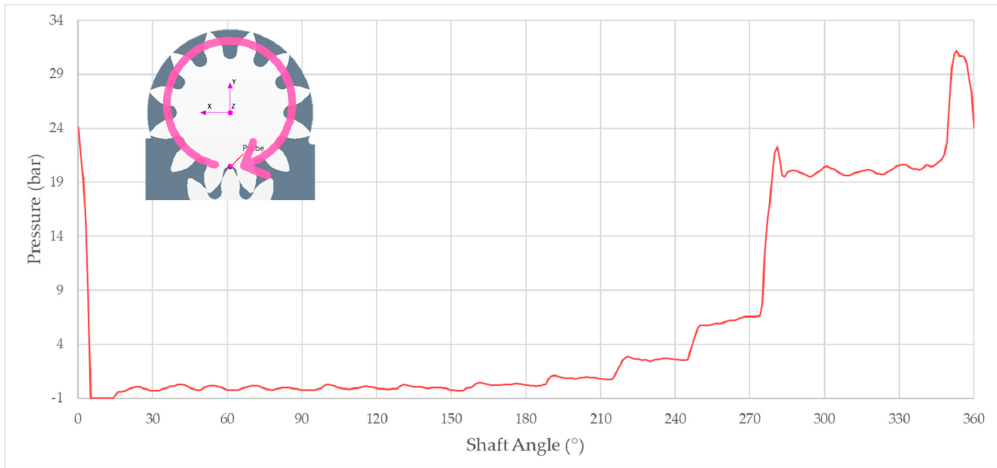
Figure 13. Pressure within a displacement chamber of the pump during an entire revolution of the driving shaft. On the top left corner, the initial position of the monitoring point is reported.